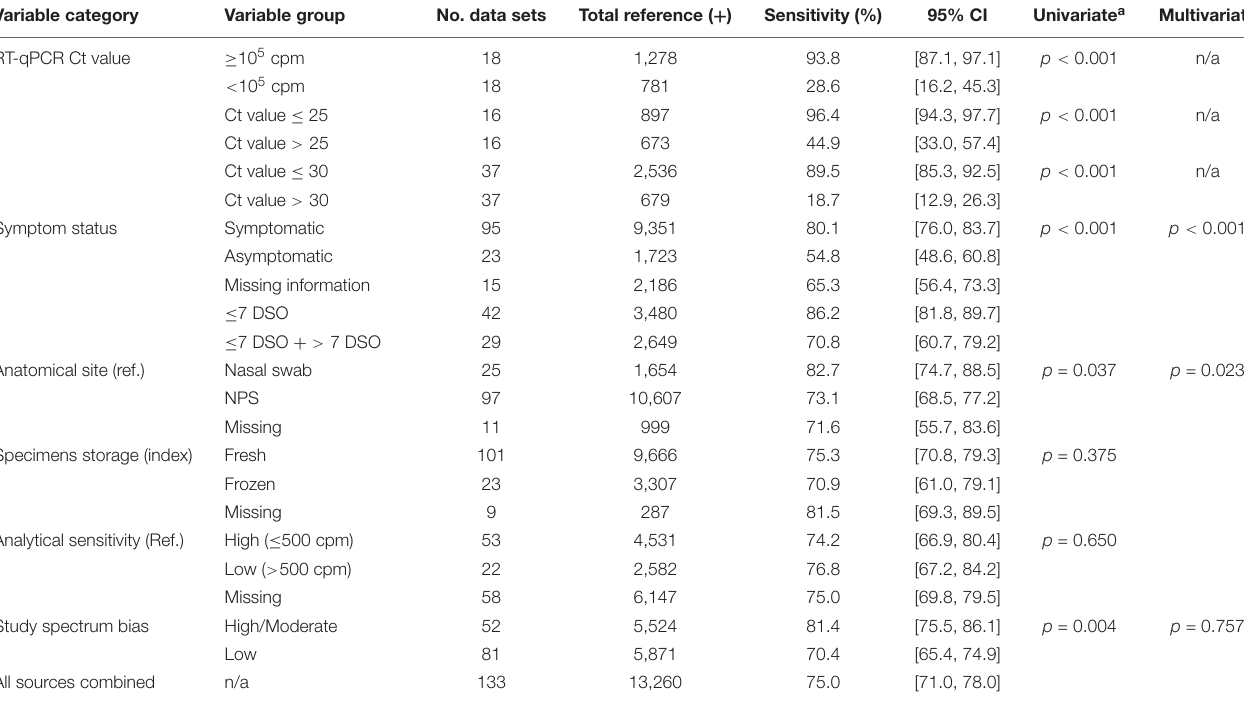
TABLE 3 | Diagnostic performance (sensitivity) for antigen testing, with RT-qPCR as reference, stratified by different population and experimental factors. Variable